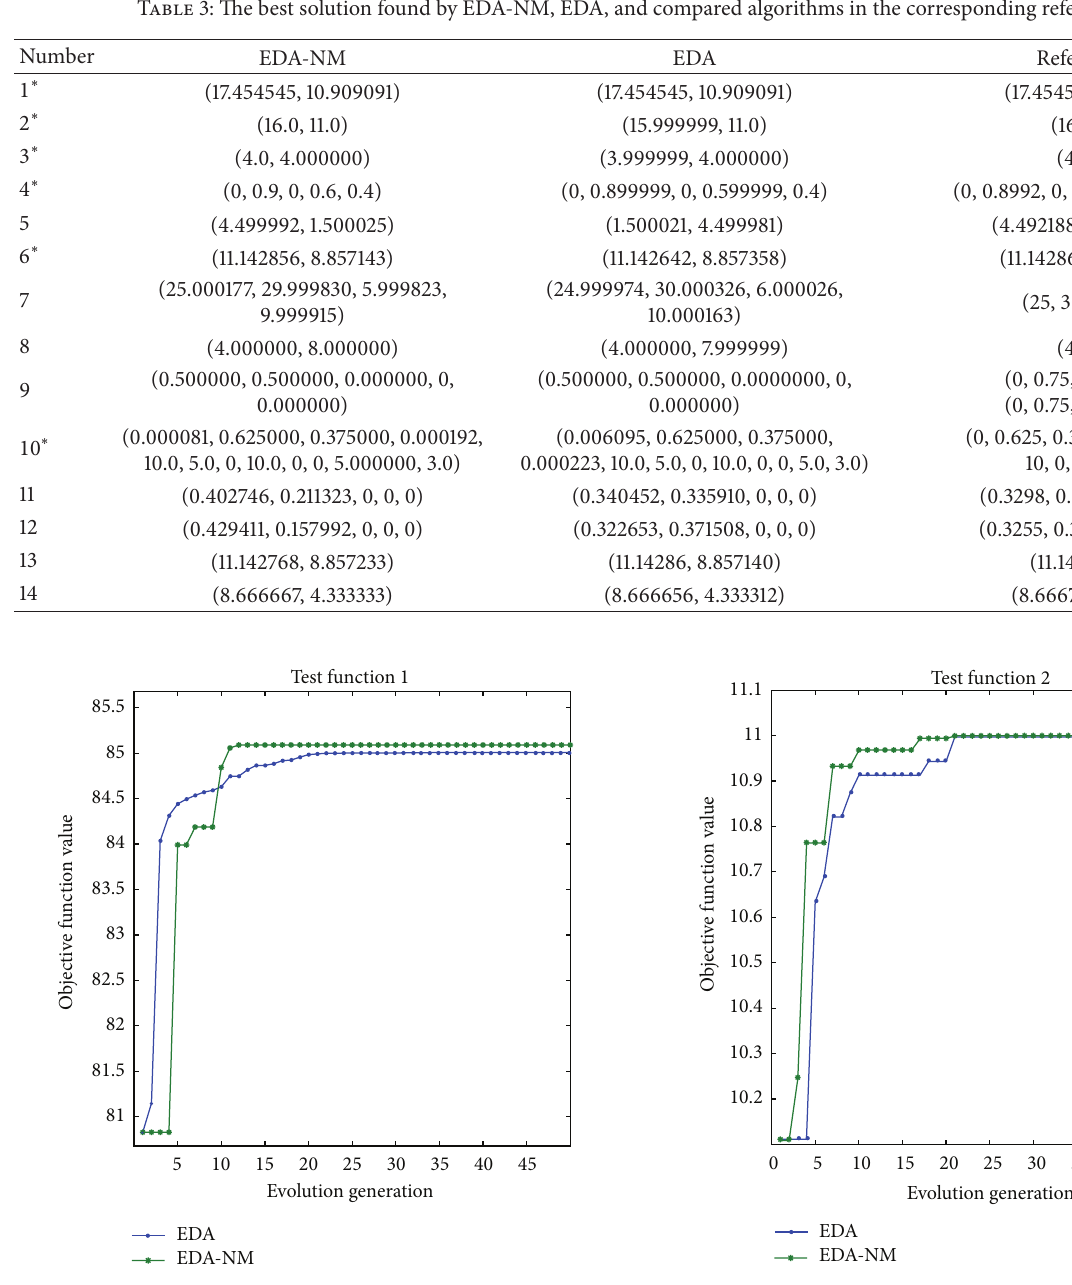
Figure 1: Convergence figure on test problem 1. Figure 2: Convergence figure on test problem